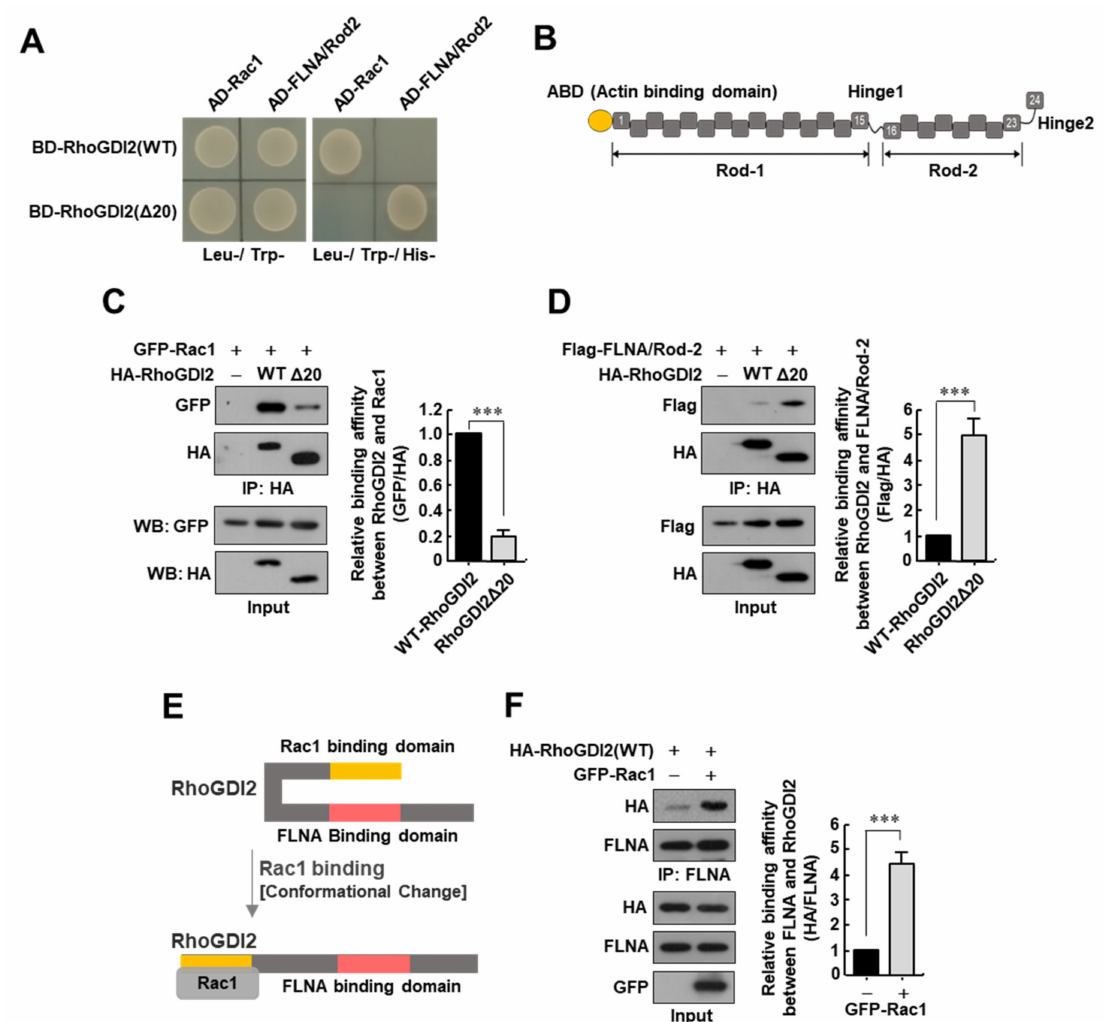
Figure 1. Interaction between RhoGDI2 and Rac1 is a prerequisite for RhoGDI2 to interact with Filamin A. ( A ) Yeast two-hybrid experiments to see the interactions between wild type RhoGDI2 or RhoGDI2 ∆ 20 and the Rac1 or Rod2 domain of Filamin A. ( B ) Schematic diagram of Filamin A structure. ABD; actin-binding domain, Rod-1 and Rod-2; immunoglobulin-like tandem repeat domains. ( C ) Interaction between exogenous Rac1 with wild type RhoGDI2 or RhoGDI2 ∆ 20. HEK293T cells transfected with indicated constructs were immunoprecipitated and analyzed by Western blot ( left ). The data are representative of three independent experiments, and relative GFP and HA levels were quantified using ImageJ software (Version 1.53n, NIH, Bethesda, MD, USA) ( right ). ***, p < 0.001 as determined by t -test. The uncropped immunoblot images can be found in Figure S1. ( D ) Interaction between exogenous Rod2 domain of Filamin A (FLNA/Rod-2) and wild type RhoGDI2 or RhoGDI2 ∆